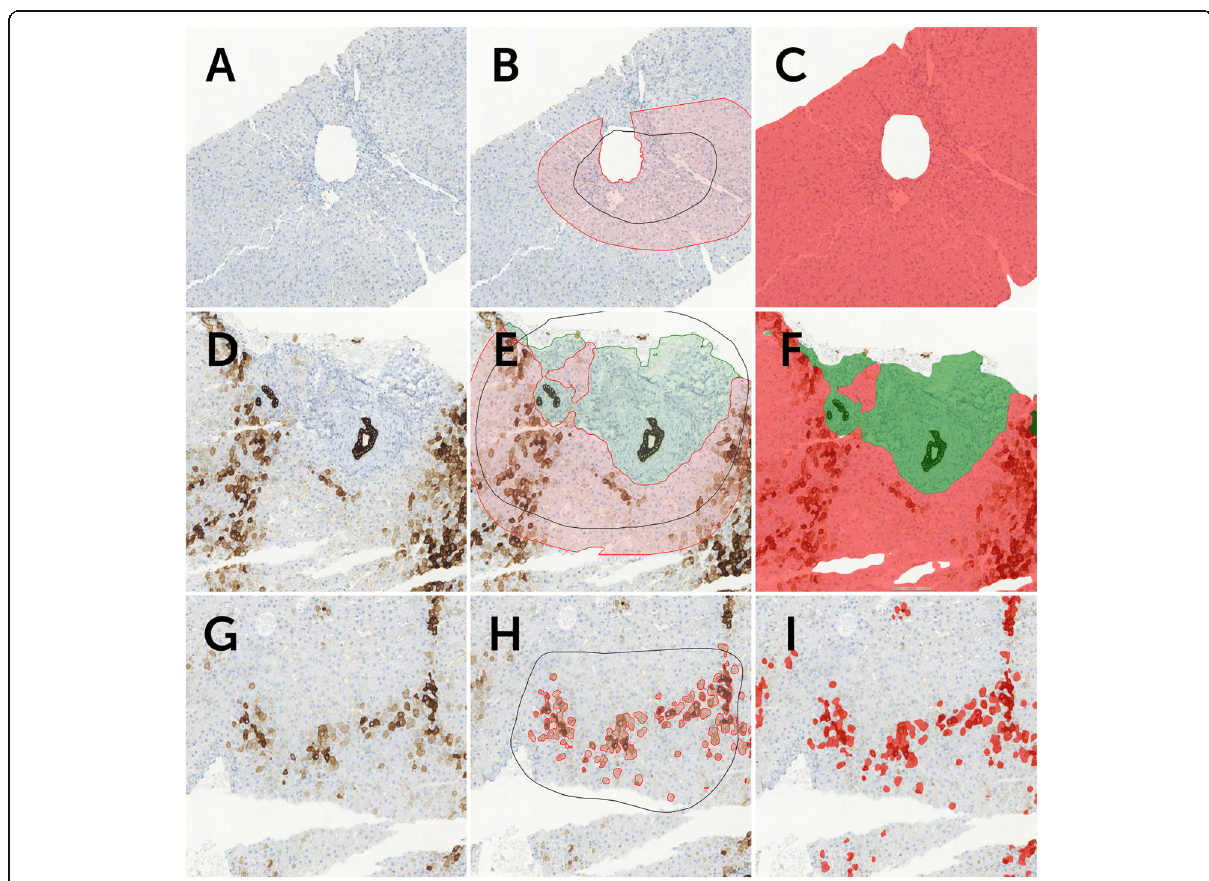
Fig. 3 a A standard cytokeratin 7 (K7) immunohistochemical stain of a liver core biopsy. b The black circle illustrates the training region, the red circle the annotation region, both drawn by a pathologist to teach the AI model to recognize liver tissue in the image. Space within the black circle but outside the red circle is considered background and not tissue. c The red area is what the K7-AI model considers liver tissue. d The same K7 stain of the same liver biopsy specimen with e training annotations drawn by a pathologist to teach the AI model the difference between portal areas and liver parenchyma. Within the black training regions, circled green areas represent the portal areas and red-circled areas represent parenchyma. f K7-AI model inference mask, meaning the interpretation of the AI model of the specimen. Accordingly, green areas are what the AI model considers as portal areas and red areas are liver parenchyma. g Notice the multiple cholestatic DAB-positive hepatocytes in this K7-stained biopsy specimen. h Red annotation regions within the training regions (black) are the areas taught to the AI model as K7-positive hepatocytes within the liver parenchyma. i The red areas are what the K7-AI model interprets as K7-positive hepatocytes after training